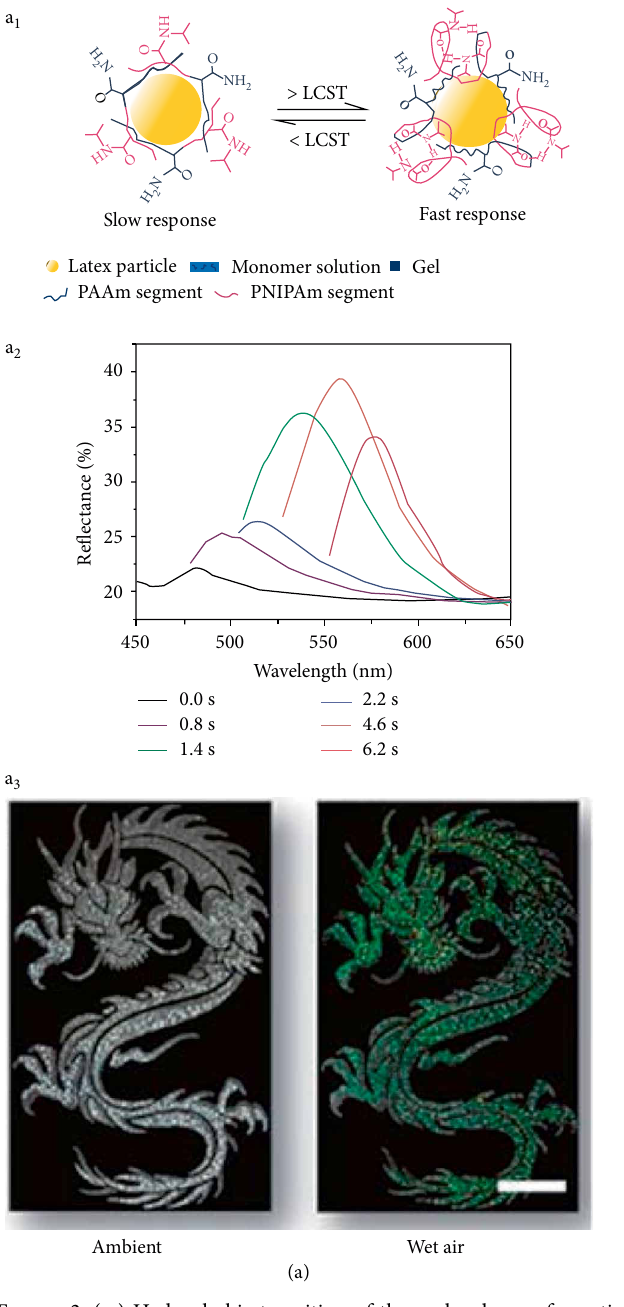
Figure 2: (a ) Hydrophobic transition of the molecular conformation of PAAm-co-PNIPAm incorporated in the PC microdot above its 1 ) Changes in reflectance spectra of the PC image with time. (a ) Colour photographs of dragon images taken at low (left) and high LCST. (a 2 3 (right) concentration of wet air. Adapted from [155]. (b) Patterns printed on a modified PDMS film with different contact angle and vapor. Adapted from [156]. (c) Covert-overt transformation of SAPC patterns on a chemical bottle, a bare glass, a paper bill, and a credit card for anti-counterfeiting applications. Adapted from [146]. (d) Patterns were shown at viewing angle of 70° and 10º with colour-filled contour map of red and green regions. Adapted from